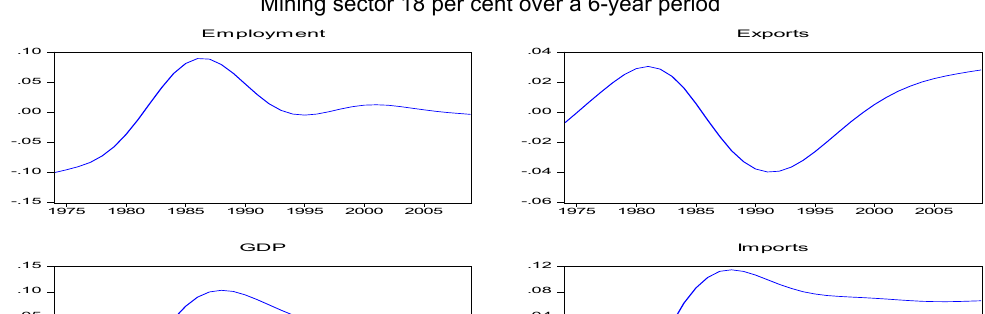
Agricultural sector 18 per cent over a 6-year